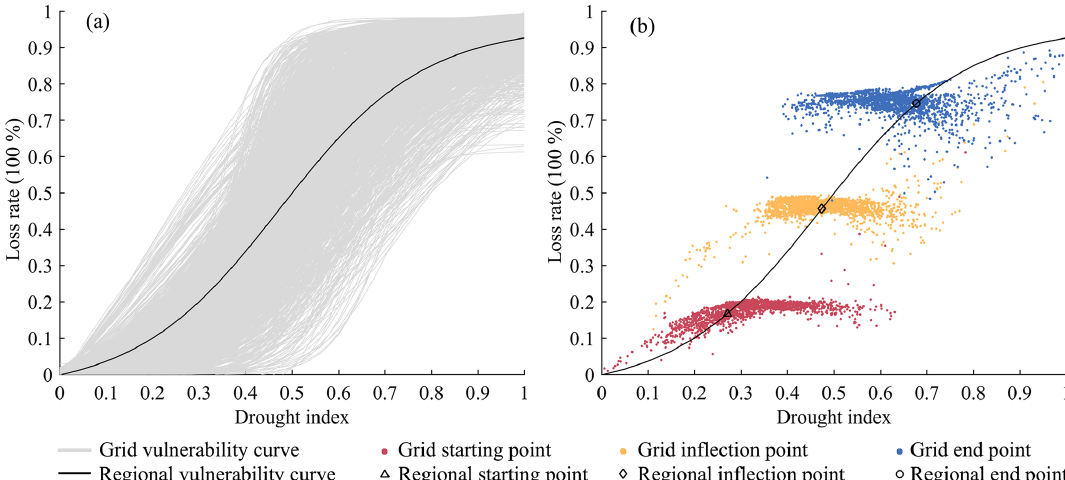
Figure 5. Distribution of (a) regional and grid vulnerability curves and (b) their three key points. The regional vulnerability curve is fitted by all drought index and loss rate sample data in the